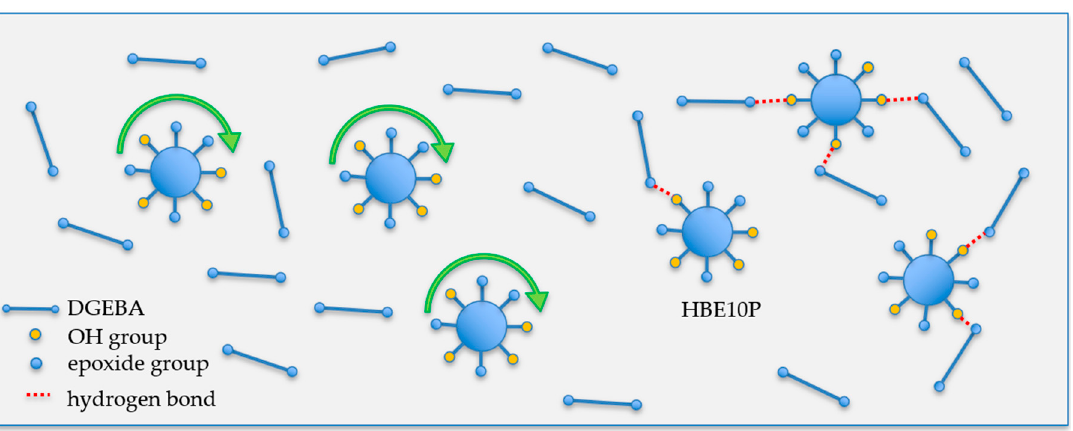
Figure 6. The effects of ball-bearing, globular and non-entanglement structure, and hydrogen bonds on the epoxy system.